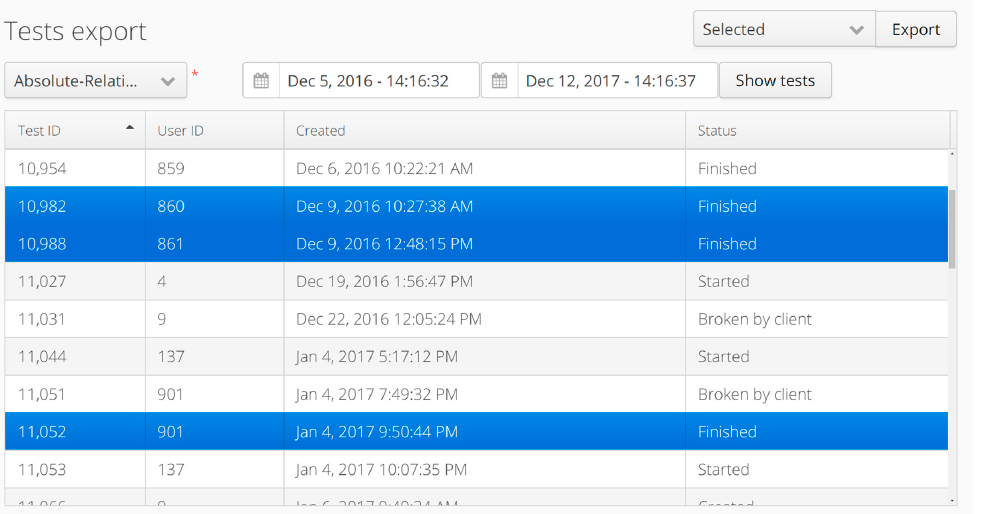
Figure 9. Export Module with finished tests (marked).